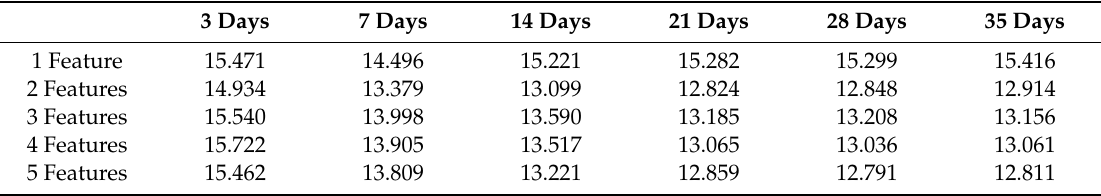
Table 2. NRMSE calculations for Plant